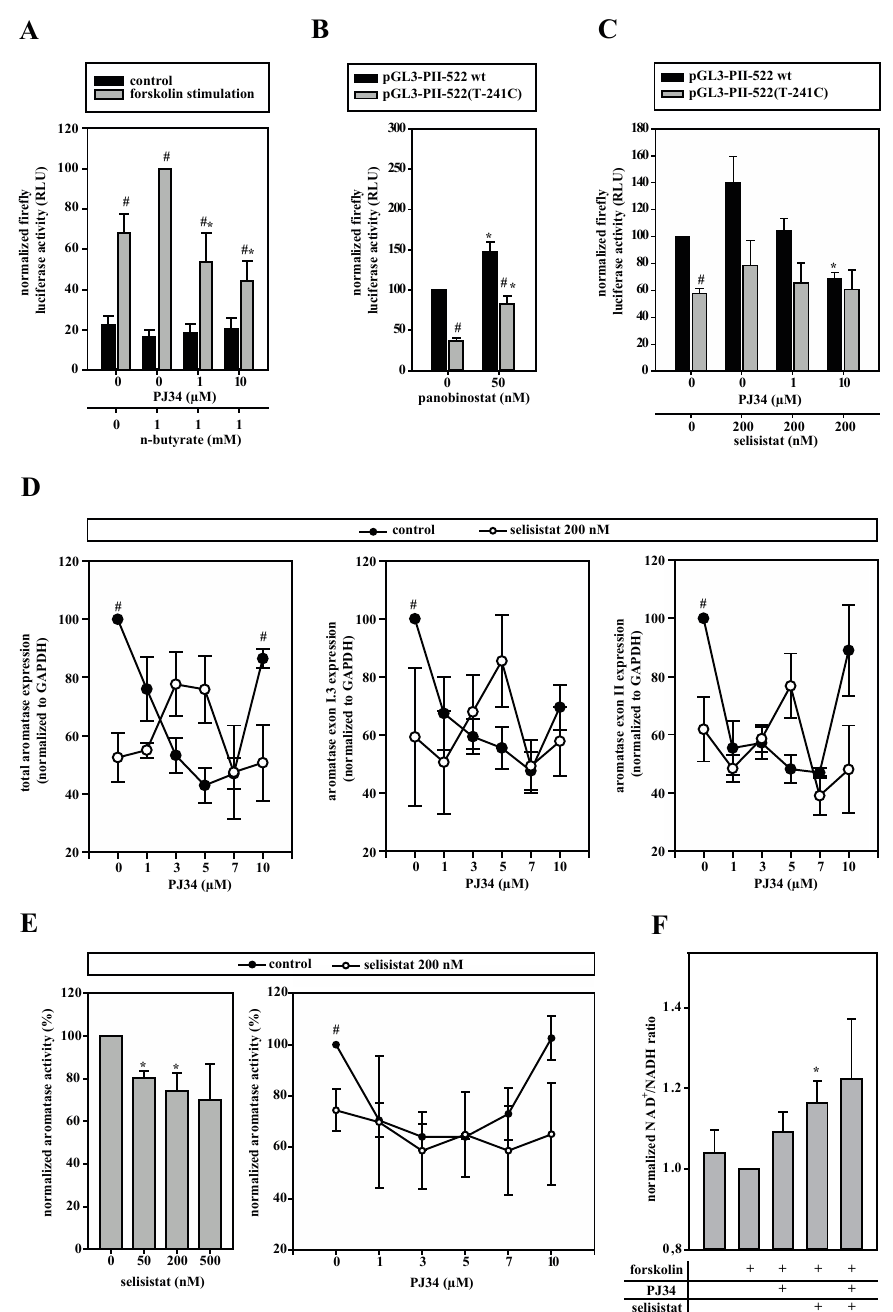
Figure 5. PARP-1 functionally interacts with histone deacetylases (HDACs). If not indicated otherwise, cells were stimulated with forskolin. ( A ) pGL3-PII-522 wt-transfected 3T3-L1 cells were incubated with n-butyrate, without or with PJ34 ( n = 6; * p < 0.05 versus n-butyrate only; # p < 0.05 versus controls). ( B ) 3T3-L1 cells transfected with pGL3-PII-522 wt or pGL3-PII-522(T-241C) were incubated with panobinostat ( n = 8; * p < 0.05 versus no panobinostat; # p < 0.05 wt versus T-241C), or ( C ) with selisistat alone or in combination with PJ34 ( n = 8; * p < 0.05 versus no PJ34; # p < 0.05 wt versus T-241C). ( D , E ) Aromatase mRNA-expression or activity was measured in BAFs, which were treated with selisistat without or with PARP-1 inhibitor PJ34. For better comparison, the data from BAFs not treated with selisistat (control) were taken from Figure 4E–H (control). SIRT-1 inhibition alone reduced aromatase expression and activity. ( D ) Control n = 3, selisistat n = 6; # p < 0.05 control versus selisistat; ( E ) n = 3; * p < 0.05 versus no selisistat; # p < 0.05 control versus selisistat). ( F ) The increased NAD + / NADH ratios were measured in forskolin-stimulated BAFs with the inhibition of PARP-1 (5 µ M PJ34) or / and SIRT-1 (200 nM selisistat) ( n = 3; * p < 0.05 versus forskolin